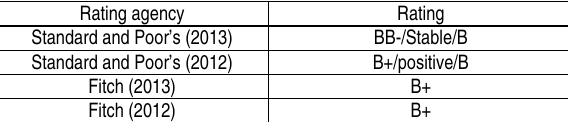
Table 1. Ratings, endorsements and